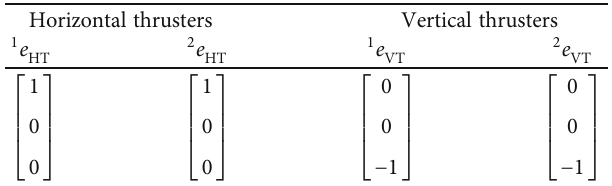
Figure 11: Diagram of thruster con fi guration: (a) rear view; (b) top view. Table 5: Position vectors for thruster con fi guration of the Lingyun. Table 6: Orientation vectors for thruster con fi guration of the Horizontal thrusters